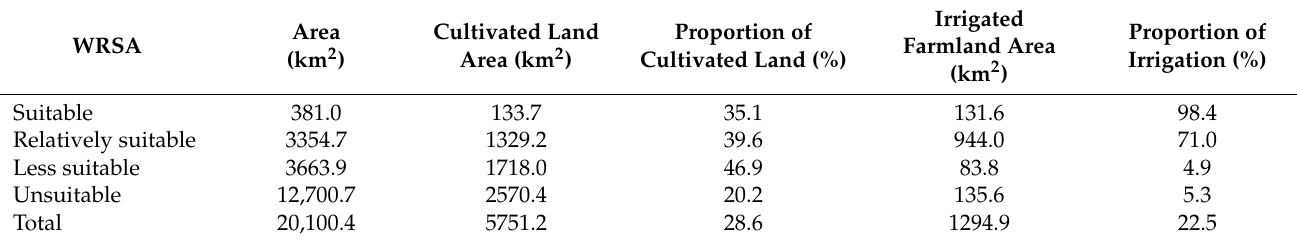
Table 3. The distribution of cultivated land under different WRSA grades.